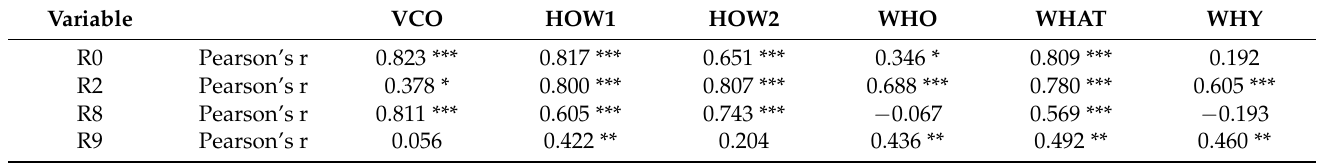
Table 4. Pearson’s correlations r among BM elements and CE strategies of CR COMPANIES.